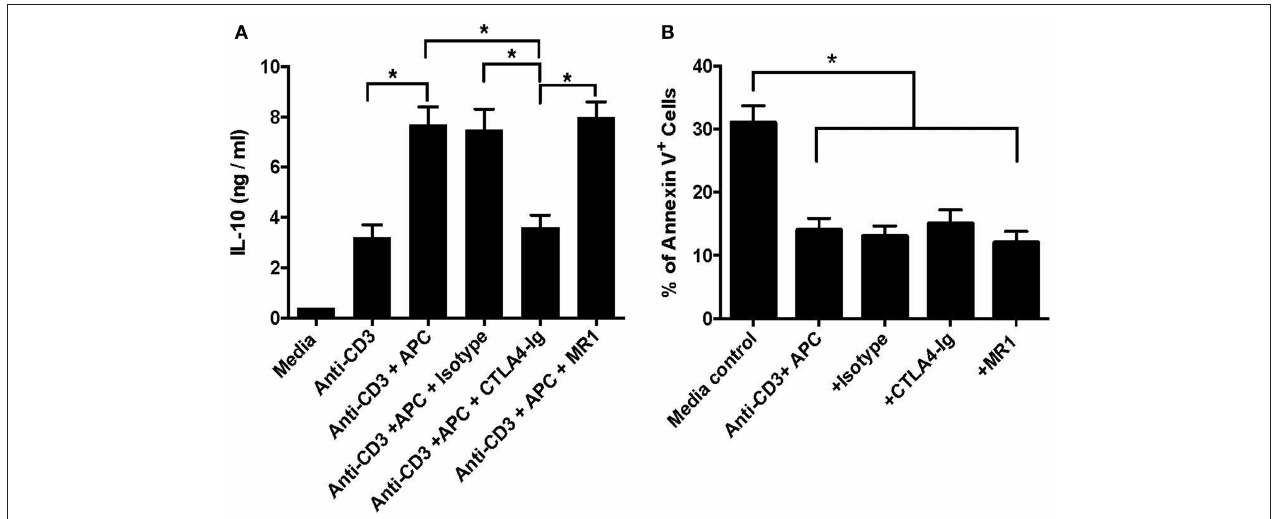
FIGURE 5 | Costimulatory blockade of B7/CD28 decreases IL-10 production by CD8 + CD122 + PD-1 + Tregs in vitro but does alter their survival. CD8 + CD122 + PD-1 + Tregs were activated in vitro with anti-CD3 Ab in the presence of CD3-depleted splenocytes serving as syngeneic APCs. MR1 or CTLA4-Ig was also added to the culture in some groups. 5 days later, IL-10 production in the supernatant was measured via ELISA (A) . In other experiments, the similarly cultured cells were stained with annexin V and analyzed for their apoptosis (B) . Data are presented as mean ± SD. One representative of three separate experiments is shown (* P < 0.05).